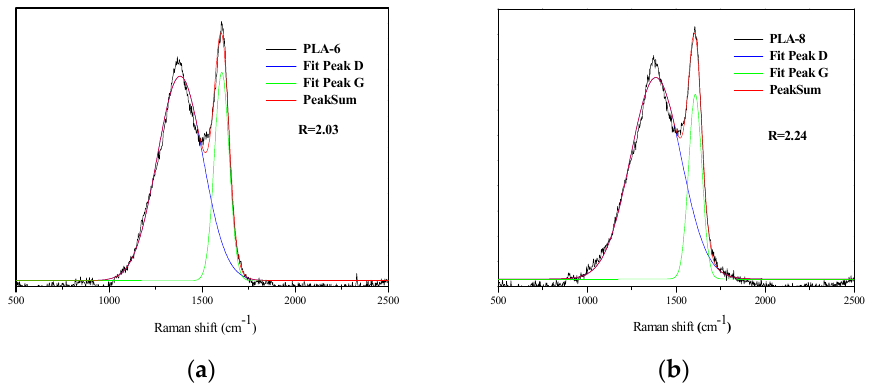
Figure 7. Raman spectroscopy analysis curves of char residue for PLA composites: ( a ) PLA-6 and ( b ) PLA-8.